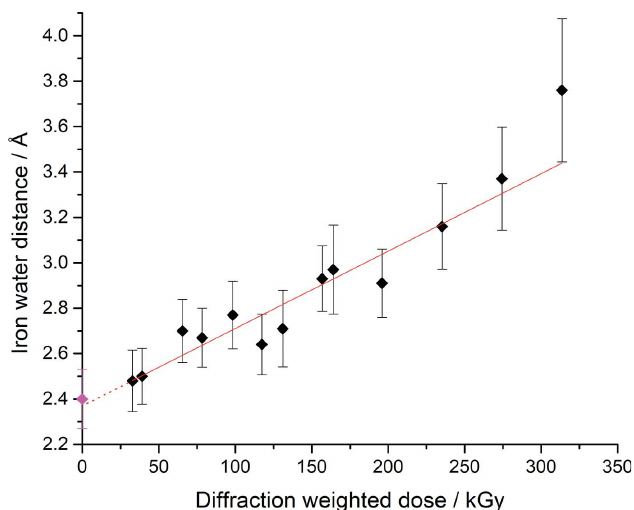
Figure 4 Plot of Fe–W1 distance as a function of X-ray dose from the two measured MSS series. The SFX structure determined using SACLA is plotted as the zero-dose point (magenta). The elongation of the bond length with dose is well fitted by a linear function (red line). The deviation at higher doses is associated with a dissociation of W1 from the immediate vicinity of the heme Fe. The extrapolation to zero dose (dashed red line) gives a value of 2.37 ( (cid:7) 0.05) A˚ which is very close to the 2.40 ( (cid:7) 0.13) A˚ value of this parameter in the SFX structure. Error bars shown are the estimated standard uncertainty in bond length obtained from the DPI value of the Fe and W1 atoms (see Materials and